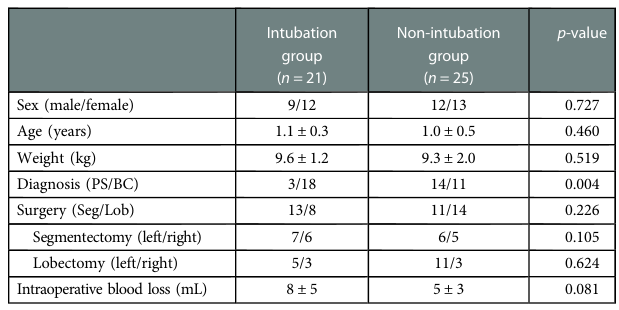
HR, heart rate; MAP, mean arterial pressure; SpO2, saturation of pulse oximetry; PETCO2, partial pressure end-tidal carbon dioxide; BIS, bispectral index; T 0 : after sedation; T 1 : after intubation or laryngeal mask placement; T2: 5 min after the start of the operation; T 3 : before the completion of the operation; T 4 : 24 h after the operation. Data are presented as number of patients (%), mean±SD, or median (interquartile range). * P <0.05 compared with T 0 . ** P <0.05 compared with T 1